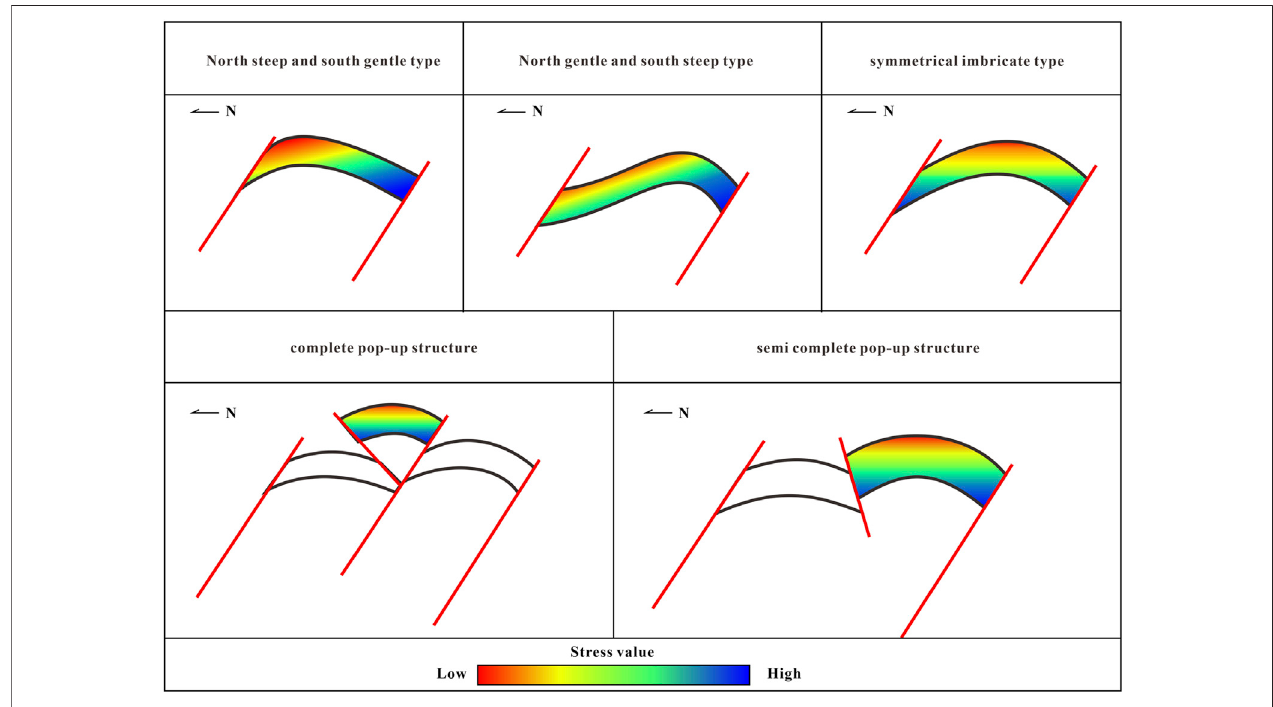
FIGURE 7 | Structural style and corresponding in situ stress distribution mode.